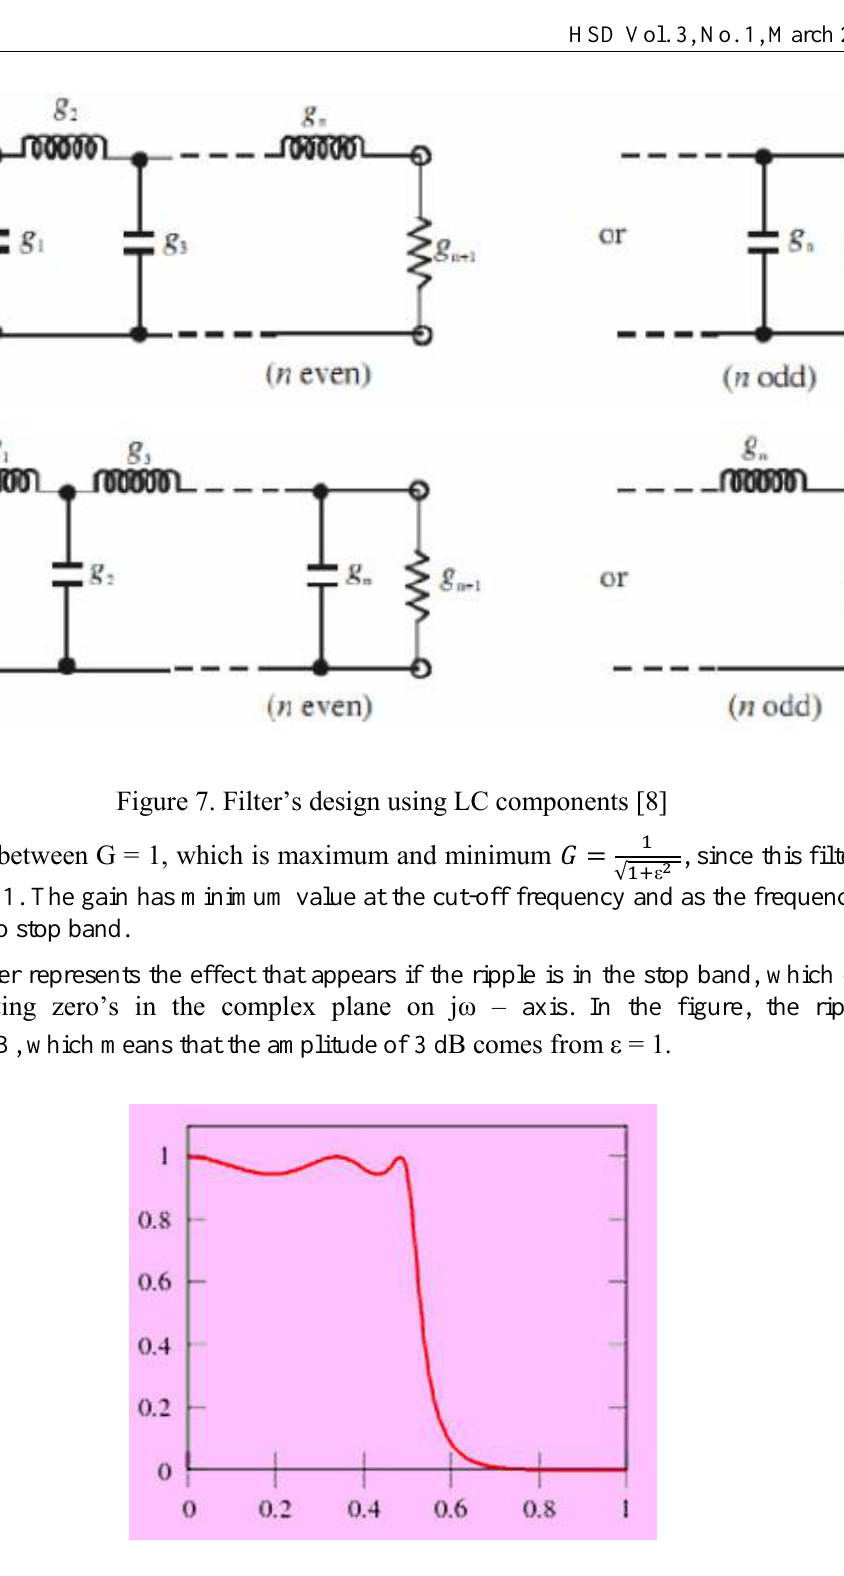
Figure 8. The behavior of type-I Chebyshev filter